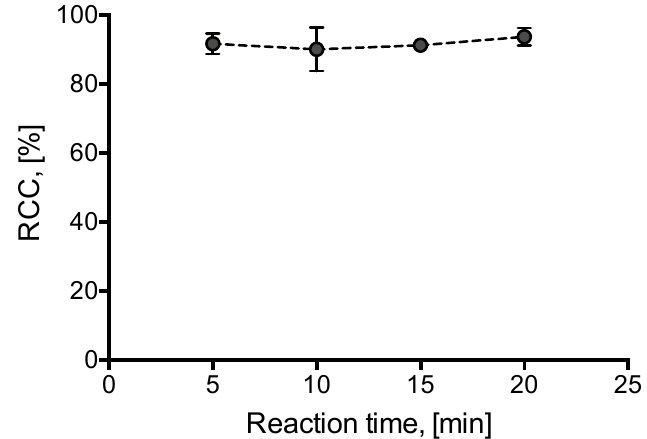
Figure 3. Dependency of RCC on reaction time. [ 18 F]Fluoride (50–200 MBq) was eluted from the respective anion exchange cartridge (see legend of Figure 1) with a solution of 1 · OTs (11 mg, 21 µ mol) in MeOH / DMF (120 / 500 µ L) directly into a solution of Cu(MeCN) 4 OTf (7.9 mg, 21 µ mol) in DMF (600 µ L) and the resulting solution was heated at 85 ◦ C for a given time. The reaction mixture was diluted with H 2 O (2 mL) and RCCs were determined by TLC. All reactions were carried out in the self-made semi-automated synthesis module. All experiments were carried out in duplicate. Error bars represent standard deviations